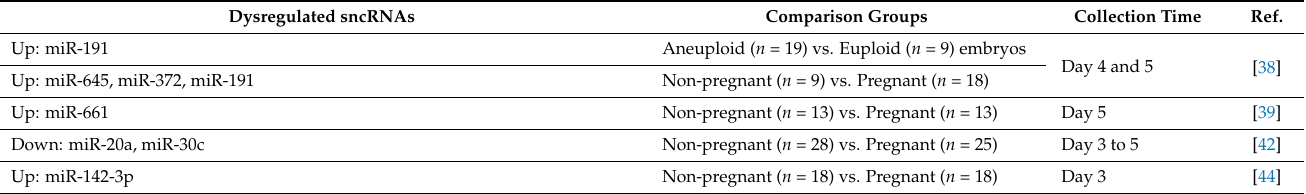
Table 3. Summary of differentially expressed sncRNAs in spent culture medium after validation by qRT-PCR in the included studies. Comparison